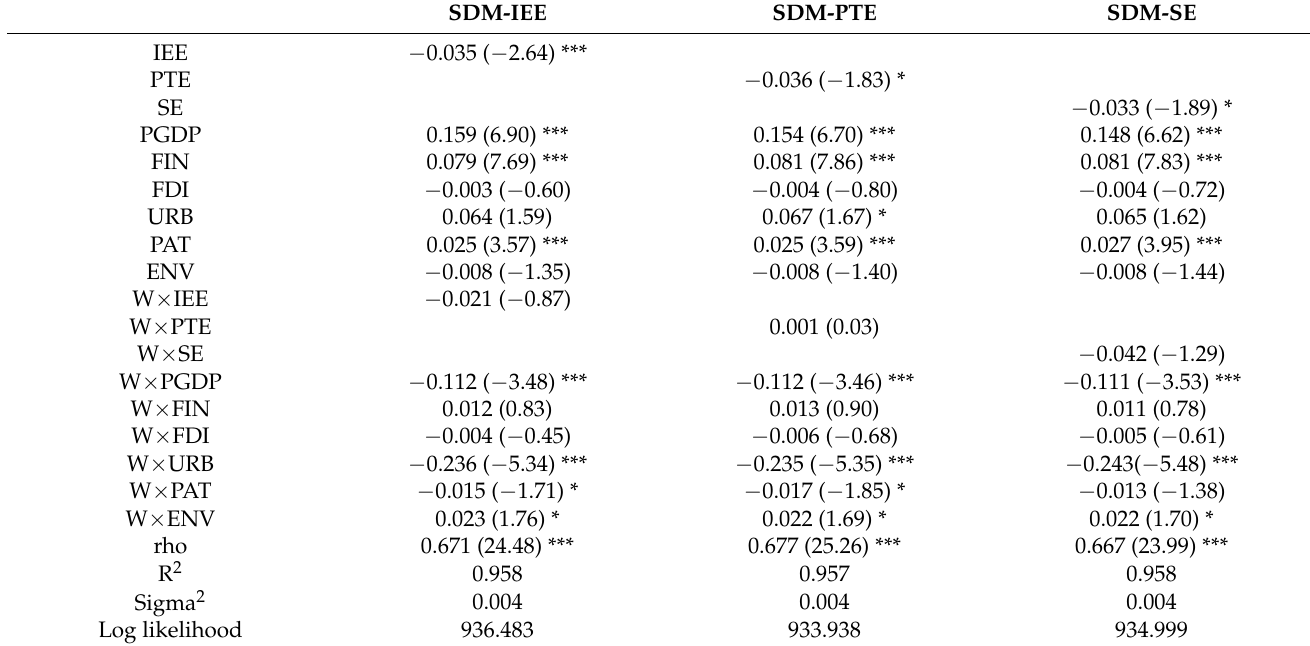
Table 3. Regression results of spatial Durbin models.